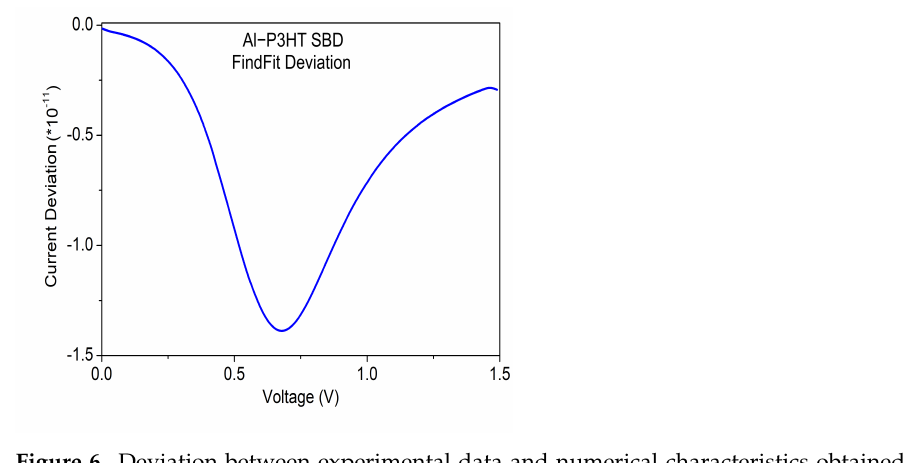
Figure 6. Deviation between experimental data and numerical characteristics obtained with the Findfit method for the organic-based